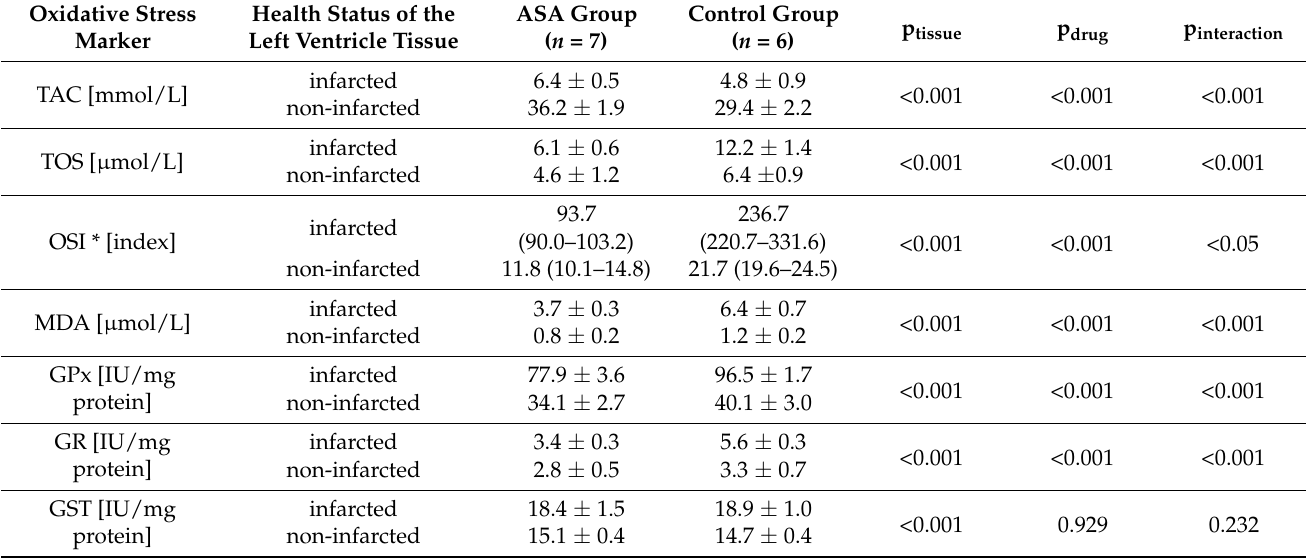
Table 2. Oxidative stress markers levels in infarcted and the non-infarcted tissues collected from the left ventricle of the heart of pigs ( n = 13) subjected to a myocardial ischemia-reperfusion protocol assessing the effectiveness of intracoronary administered acetylsalicylic acid (ASA). The results are presented as mean ± standard deviation or median (lower, upper quartile) and were analyzed using two-way